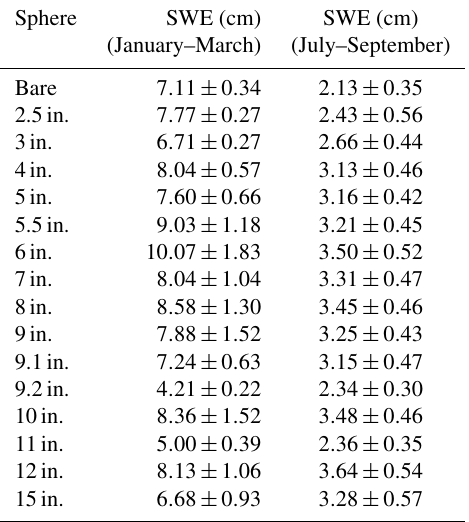
Figure 9. Unfolded ERBSS neutron flux spectra at UFS for se- lected dates in 2018; SWE calculated with the count rates of the 4in. sphere. Table 4. Snow water equivalent deduced from measured ERBSS count rates as calculated with the fit functions shown in Fig. 6 and the corresponding fit parameters listed in Table 3. Shown are the mean values from the daily values of Fig. 8, for winter times (January–March) and summer times (July–September) and their standard deviations. Sphere SWE (cm) SWE